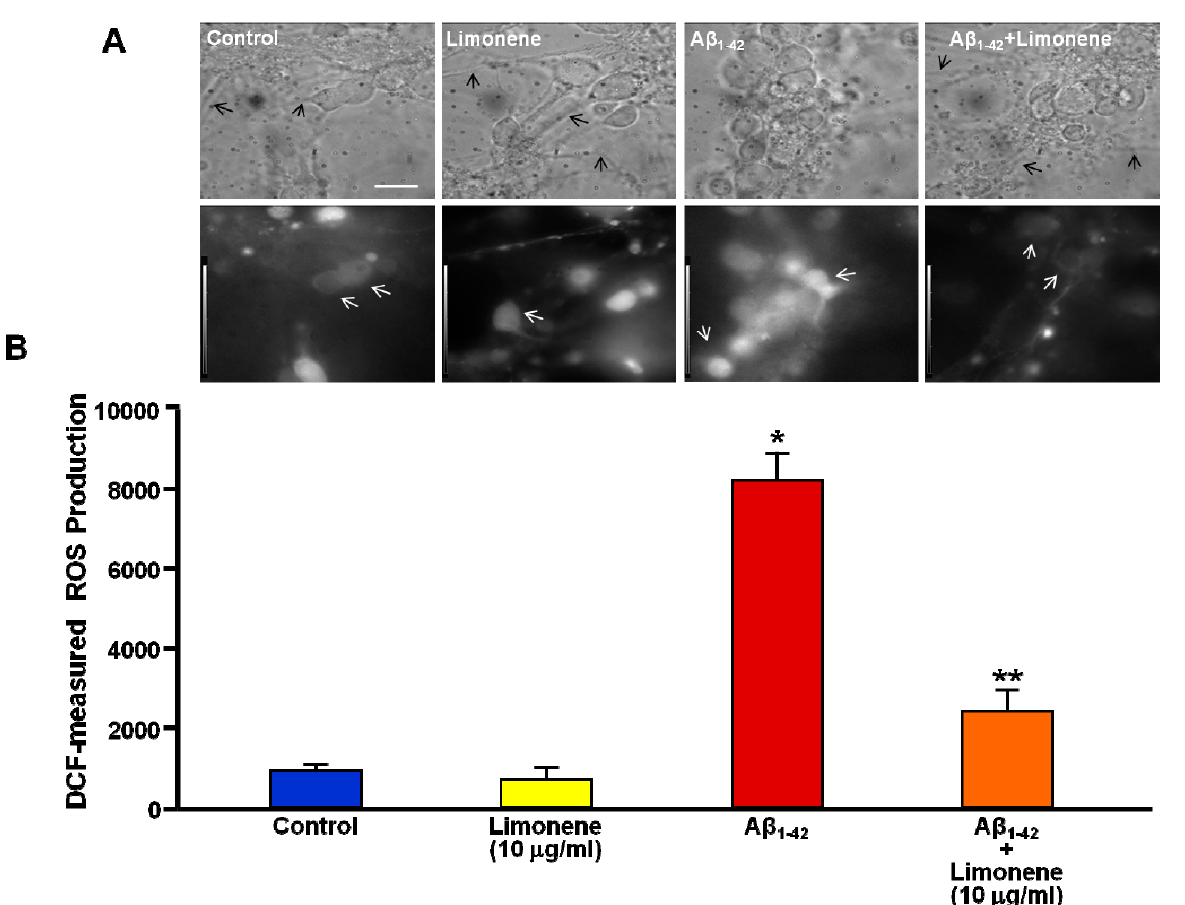
Figure 3. Effects of limonene on ROS production in primary rat cortical neurons exposed to A β 1-42 oligomers. ( A ) Representative phase-contrast (top) and corresponding DCF fluorescence images (bottom) of primary cortical neurons under control conditions, in neurons treated with limonene (10 µ g/mL/24 h), or treated with A β 1-42 oligomers (5 µ M/24 h) in the absence and in presence of limonene (10 µ g/mL, 30 min pre-treatment). Black and white arrows indicate differences occurring at the level of prolongations and fluorescence intensity, respectively. Scale bar: 20 µ m. ( B ) Quantification of intracellular ROS production in A. Data are depicted as DCF fluorescence values (arbitrary units) expressed as mean ± SEM of three independent experimental sessions. * p < 0.05 vs controls; ** p < 0.05 vs A β 1-42 .